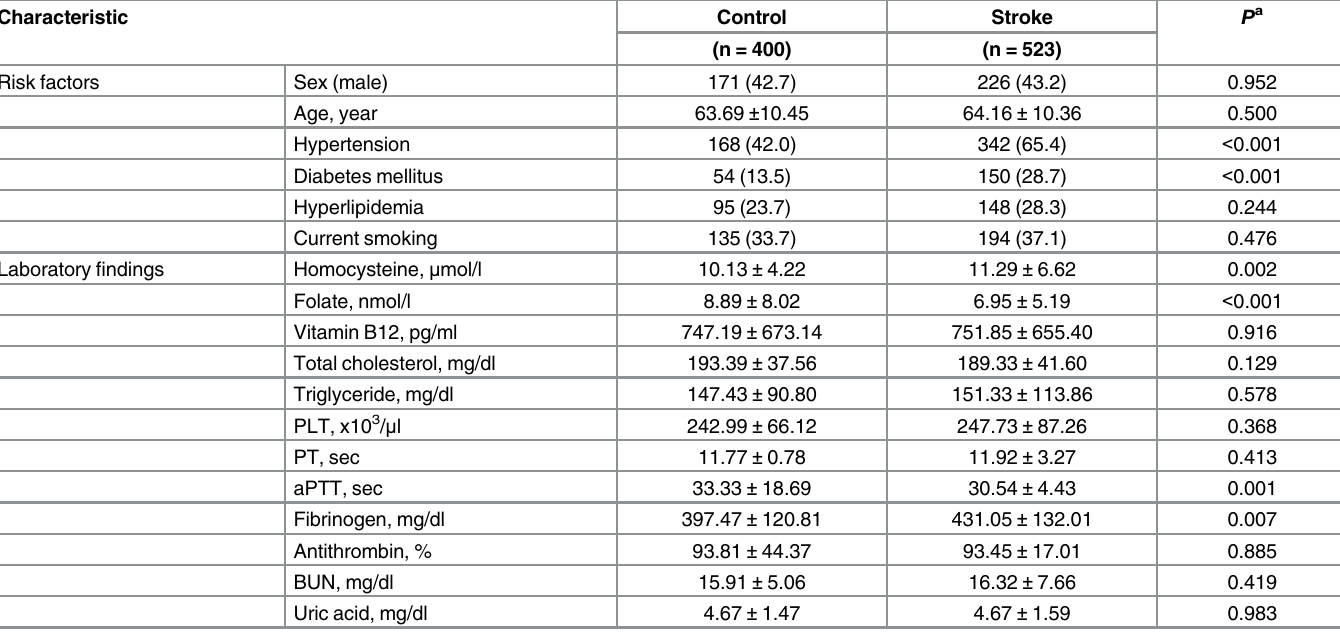
Table 1. Baseline characteristics in ischemic stroke patients and control subjects.